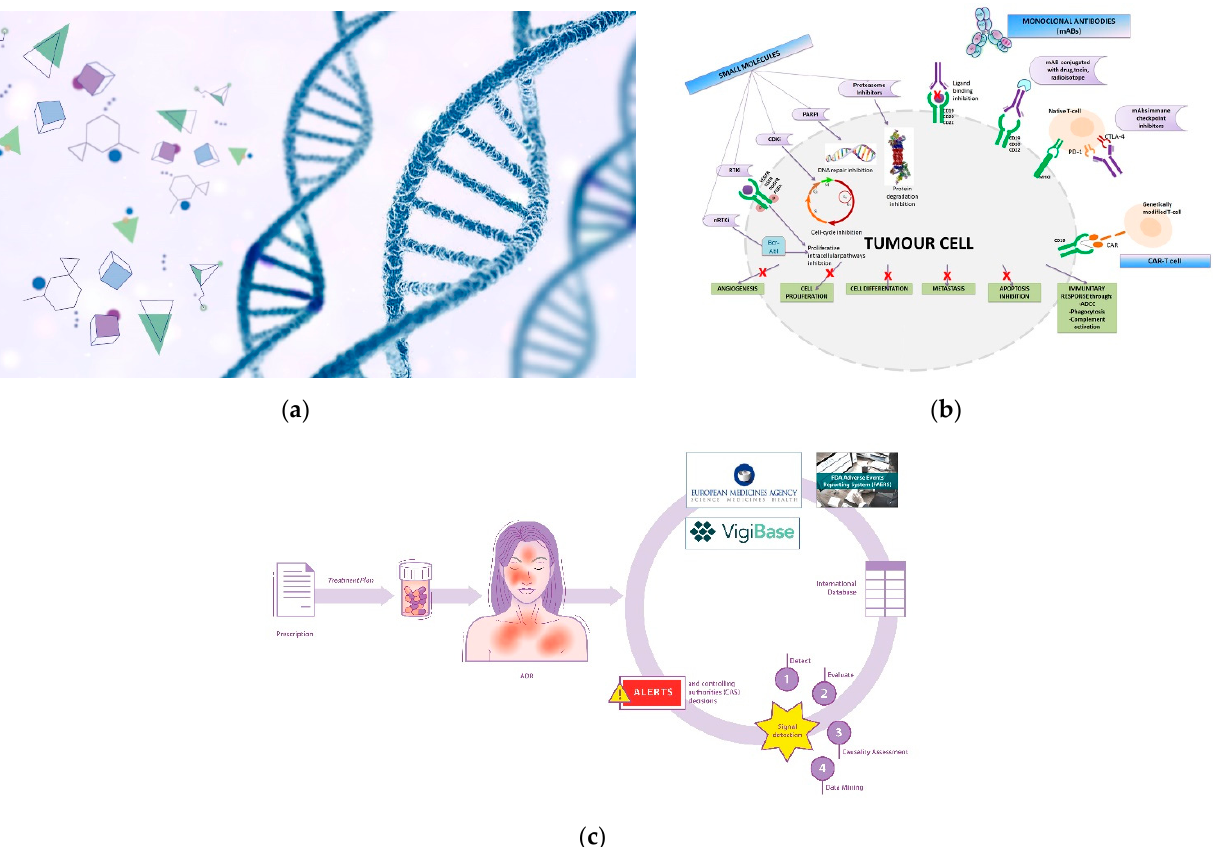
Figure 1. ( a ) Genetic therapy involves the interaction between pharmacological molecules and the genetic material of the cell; ( b ) Targeted therapy involve specific sites to interact with molecular targets in the cell. BCR-ABL: Breakpoint Cluster Region-Abelson gene; nRTKi: Non-Receptor Tyrosine Kinase inhibitors; RTKi: Receptor Tyrosine Kinase inhibitors; VEGFR: Vascular Endothelial Growth Factor Receptor; EGFR: Epidermal Growth Factor Receptor; PDGFR: Platelet-Derived Growth Factor Receptor; FGFR: Fibroblast Growth Factor Receptor; CDKi: Cyclin-Dependent Kinase inhibitors; PARPi: Poly Adenosine diphosphate-Ribose Polymerase inhibitors; MHCI: Major Histocompatibility Complex; PD-1: Programmed cell Death Protein 1; CTLA-4: Cytotoxic T-Lymphocyte Antigen 4; CAR: Chimeric Antigen Receptor; ADCC: Antibody-Dependent Cellular Cytotoxicity. ( c ) Pictorial rappresentation of the workflow of the International sistem of pharmacovigilance. Spontaneous reports of ADRs (adverse drug reactions) are collected from international databases (Vigibase, FAERS system and Eudravigilance) in order to generate alerts and implement post-marketing drug surveillance.